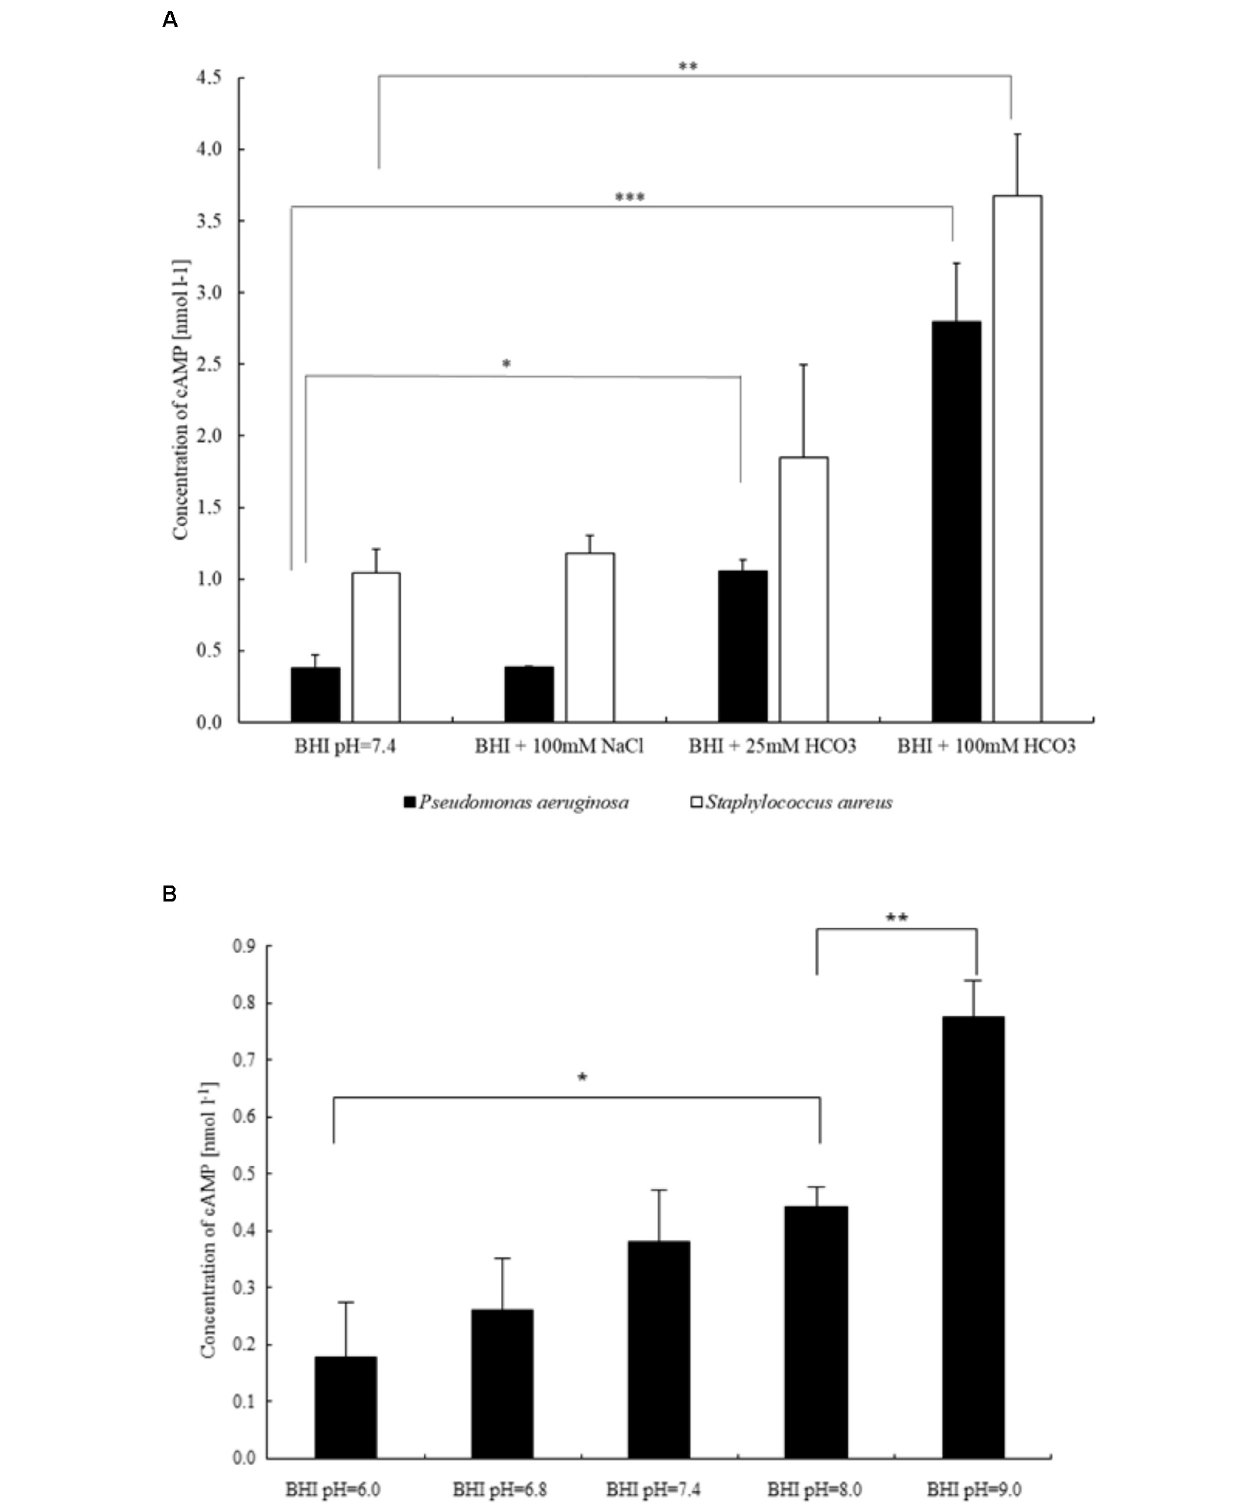
FIGURE 5 | Differences in intracellular cAMP production of bacteria influenced by (A) sodium chloride and two different concentrations of sodium bicarbonate ( P. aeruginosa and S. aureus ), and (B) external pH ( P. aeruginosa ). ∗ P < 0.05, ∗∗ P < 0.01, ∗∗∗ P < 0.001.